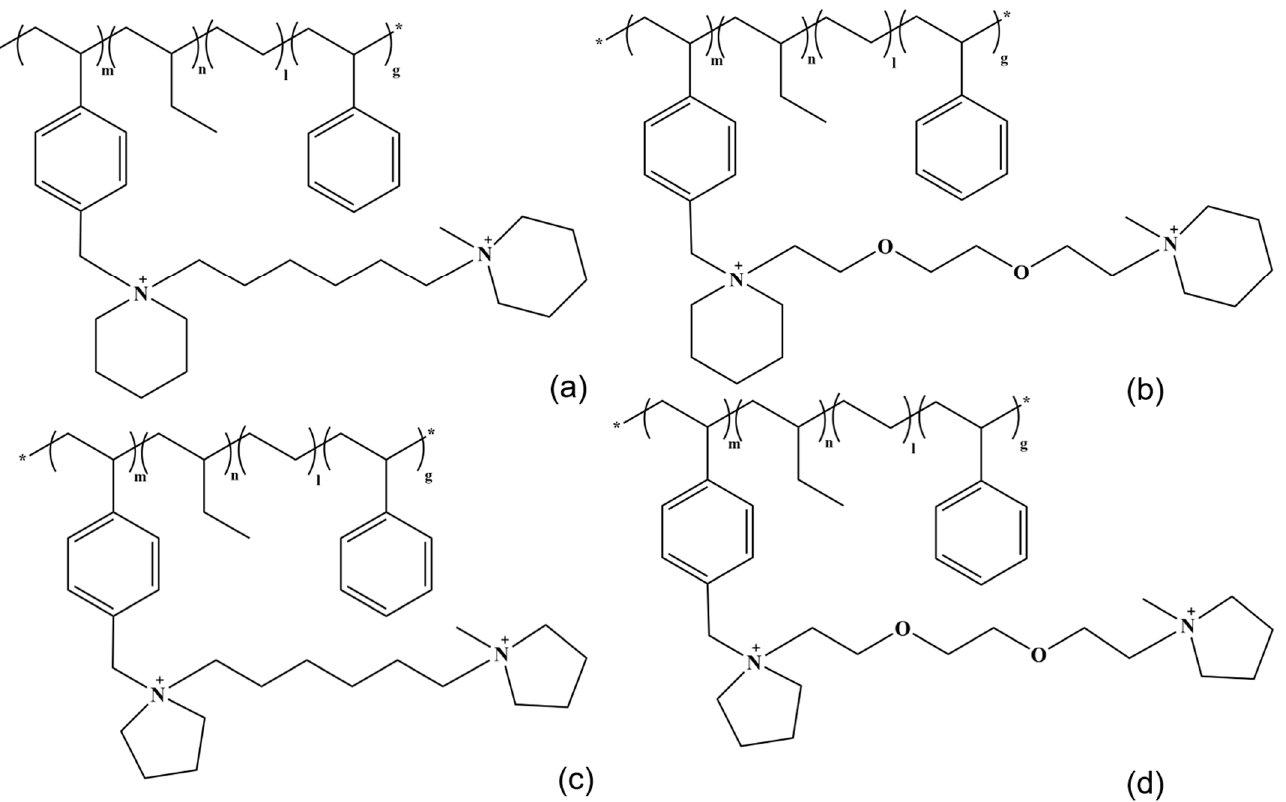
Figure 2. Different membranes structures obtained in this study: ( a ) SEBS-P2C6, ( b ) SEBS-P2O6, ( c ) SEBS-Py2C6, ( d ) SEBS-Py2O6.